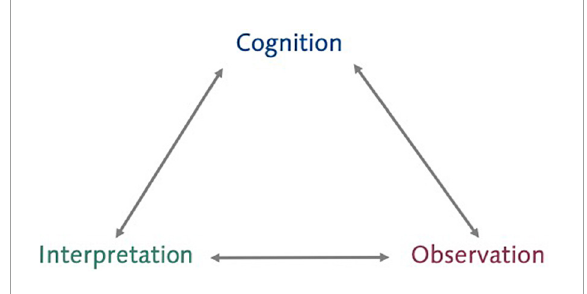
FIGURE1 Assessment triangle, adapted from Pellegrino et al.